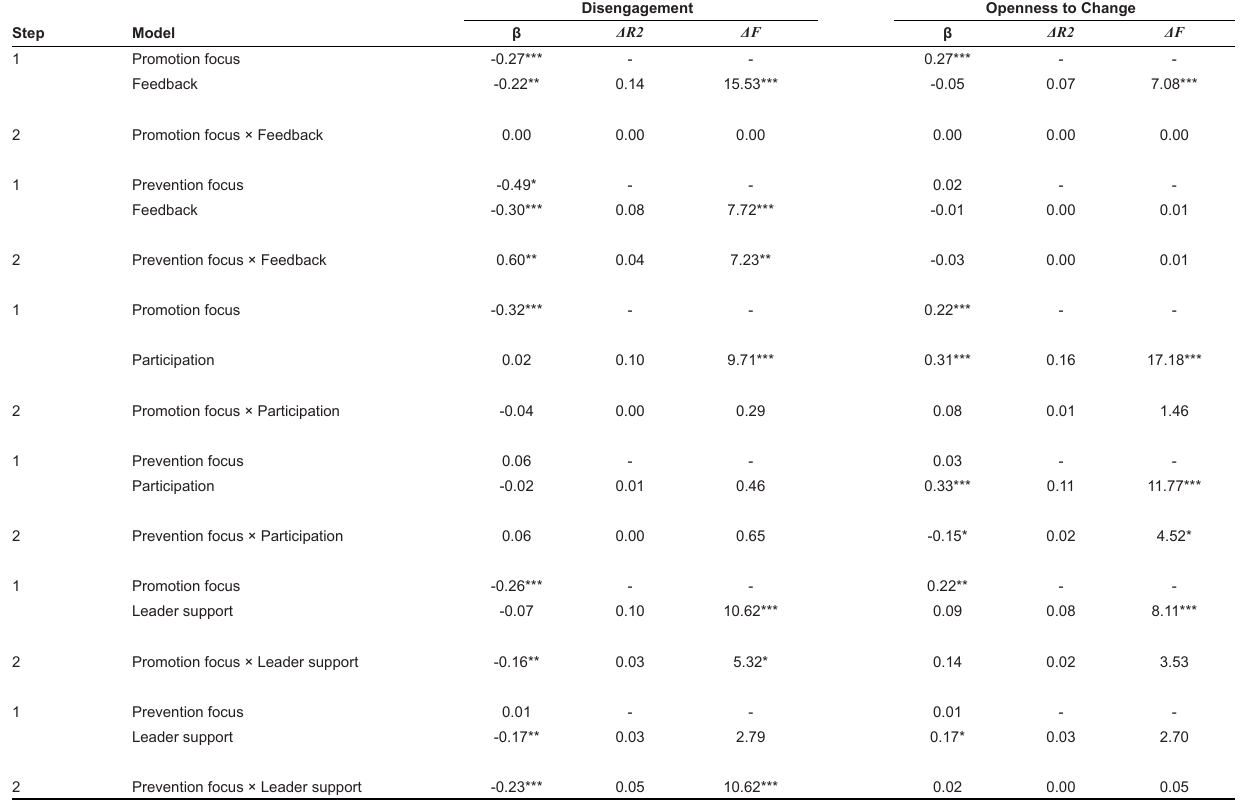
TABLE 6 Regression of disengagement and openness to change on job resources, promotion and prevention focus in sample 2 ( N